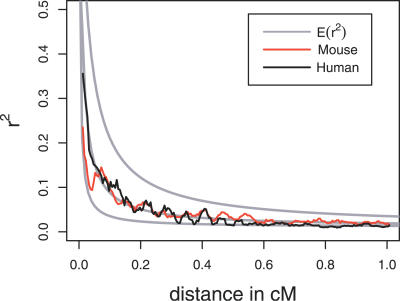
Mean LD in 94 Arizona Mice and 90 Asian Humans, Evaluated in a Sliding Window of 0.025 cMThe data are the same as in Figure 2, but physical distance has been converted to genetic distance using genome-wide averages of cM/Mb. The expected value of r
2 for a sample size of n diploids is calculated as E (r
2) = (1 / (1 + 4Nec)) + (1 / n), where Ne is effective population size and c is recombination rate (converted to cM for plotting by the Kosambi mapping function). In this case, n = 92 and Ne = 1,000, 3,000, or 10,000 (from top to bottom).